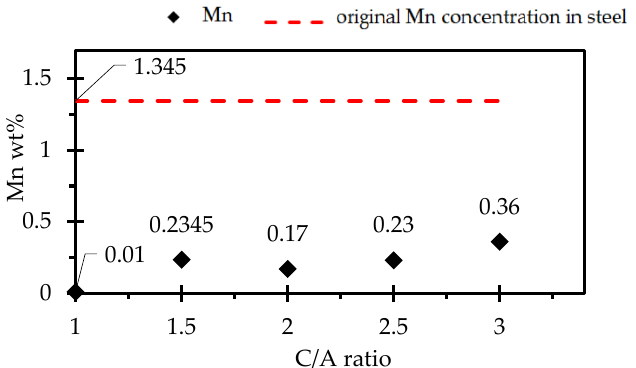
Figure 19. Total change in the manganese content of the steel depending on the C/A ratio for the 20 min interaction time.